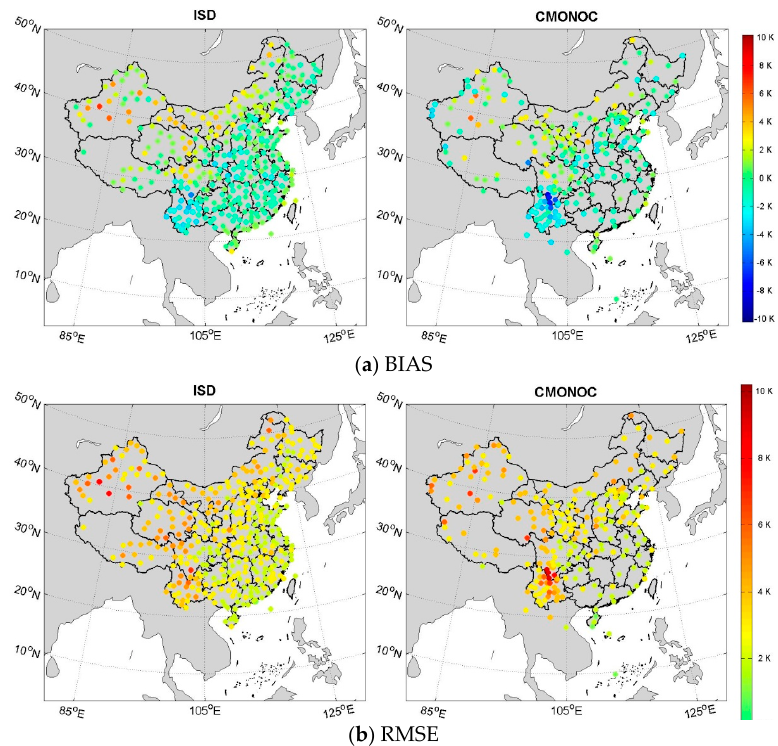
Figure 8. ( a ) BIAS and ( b ) RMSE between interpolated and measured near-ground air temperature of stations from ISD and CMONOC.